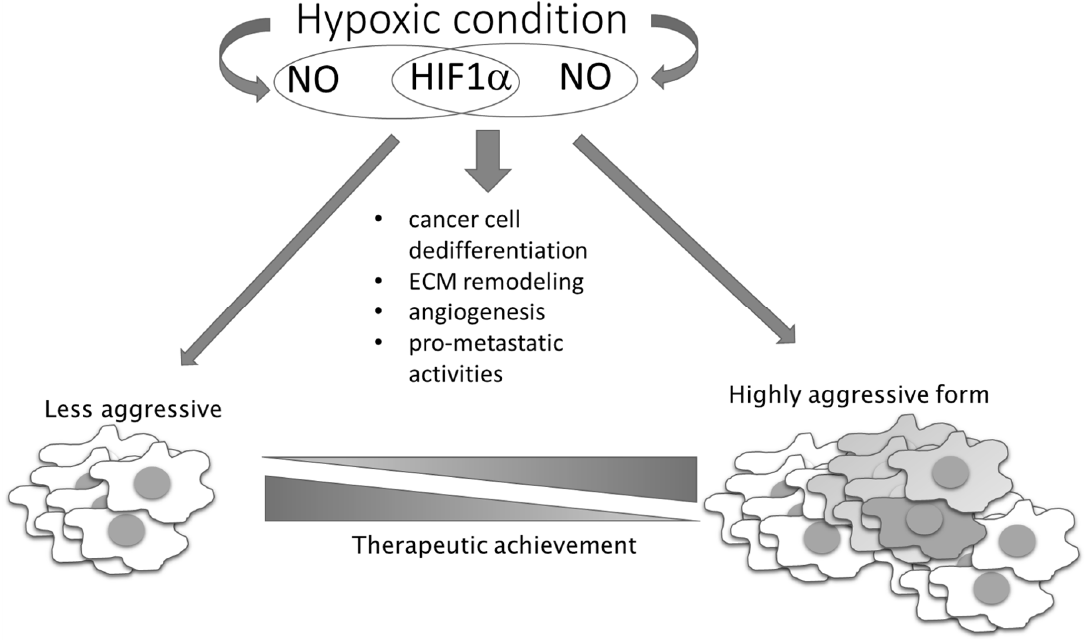
Figure 4. NO–HIF-1 input in tumor progression and therapeutic achievement. NO together with HIF-1 influences the main processes involved in the conversion of less-aggressive toward high-aggressive phenotype. HIF-1 regulates the expression of genes responsible for stem phenotype establishment, remodeling of the extracellular matrix (ECM), angiogenesis, and NO synthesis, while NO influences HIF-1 stability.